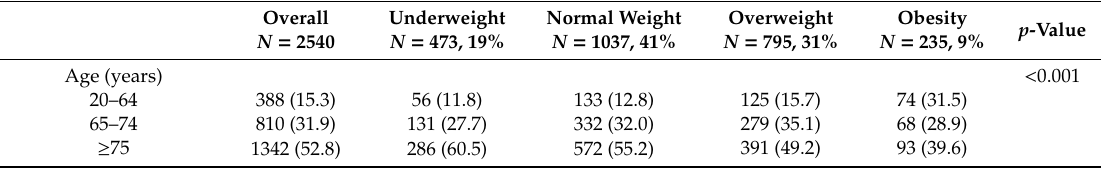
Table 2. Baseline demographic and clinical characteristics 1